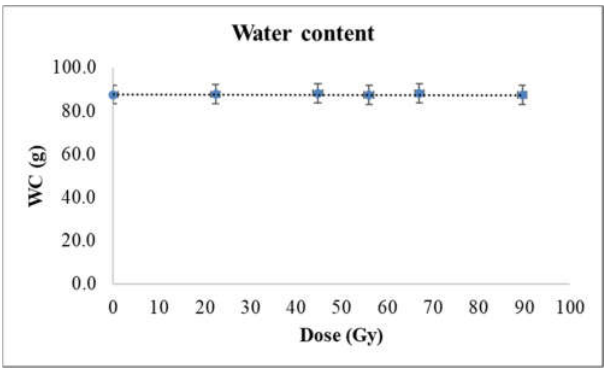
Figure 2. Water content (WC) in wheat seedlings grown from the proton beam irradiated seeds . Twenty seedlings for each experimental variant were measured.